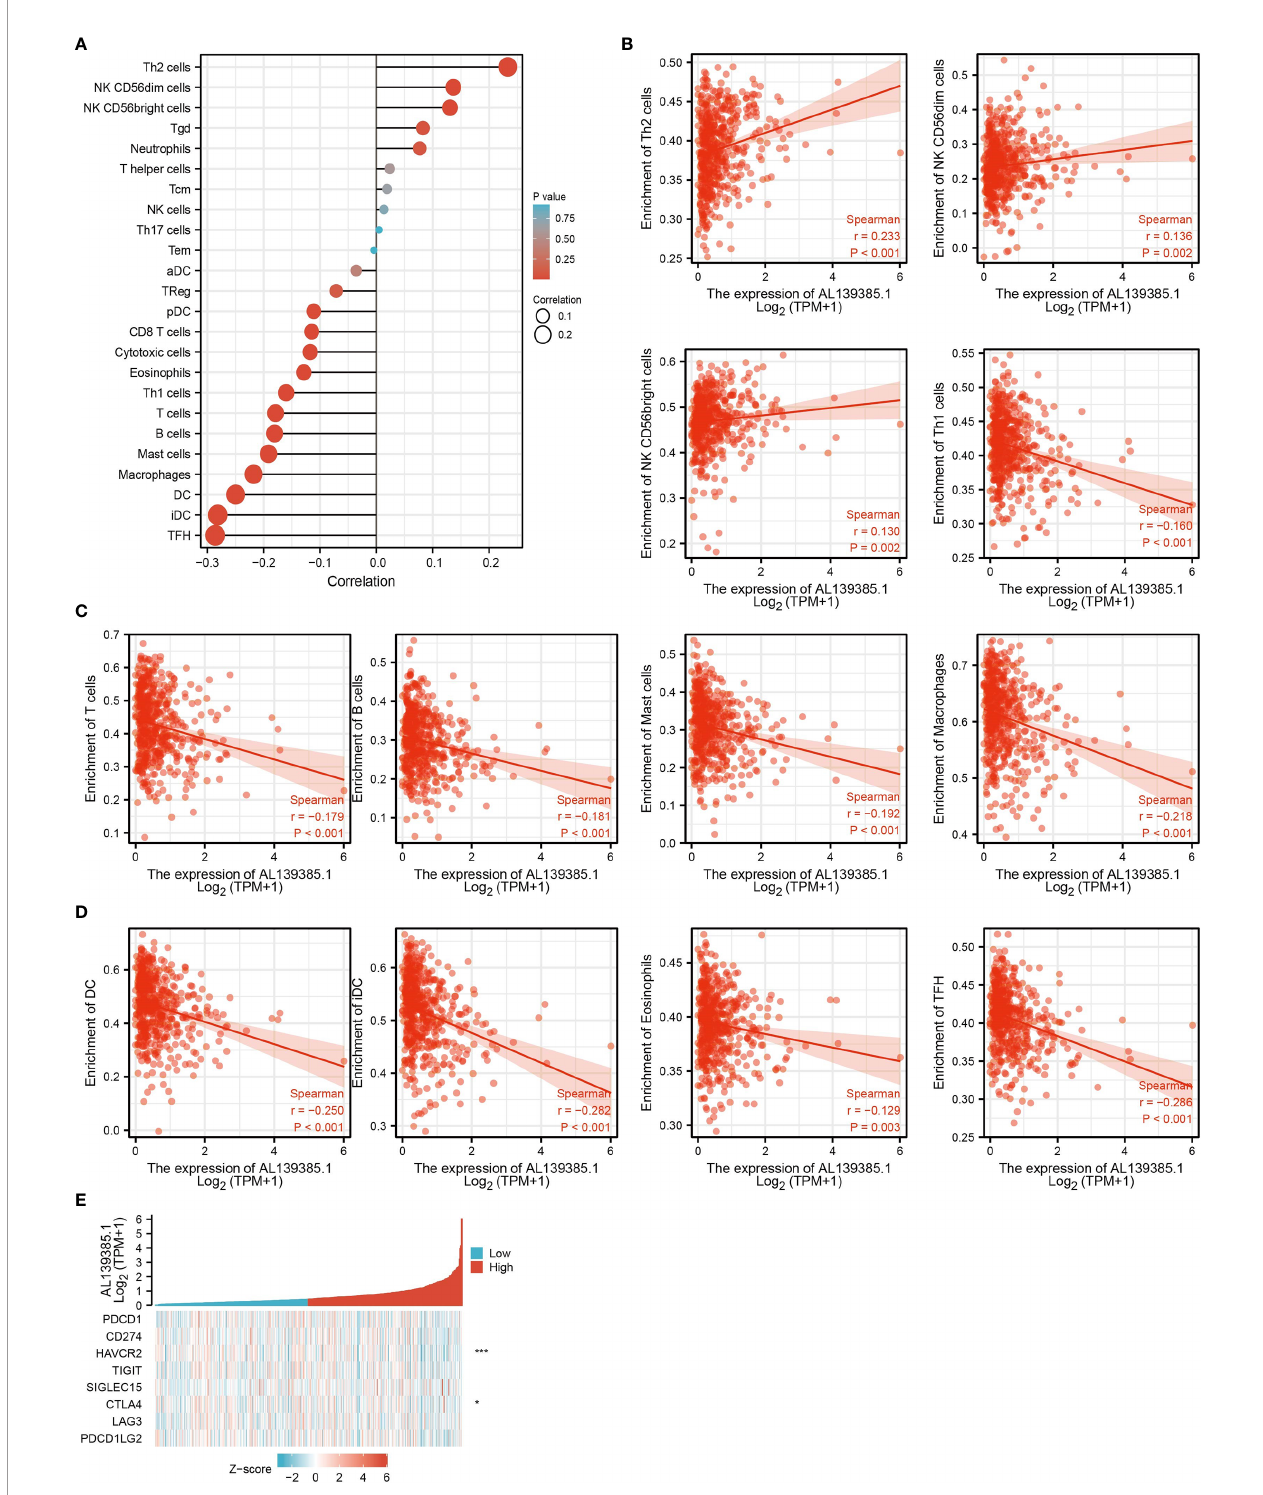
FIGURE 6 | Correlation analysis of AL139385.1 expression and in fi ltration levels of immune cells in LUAD. (A – D) The correlation between AL139385.1 expression and the in fi ltration levels of 26 immune cells in LUAD. (E) The correlation between AL139385.1 expression and immune checkpoint – related genes in LUAD. *P < 0.05, ***P <